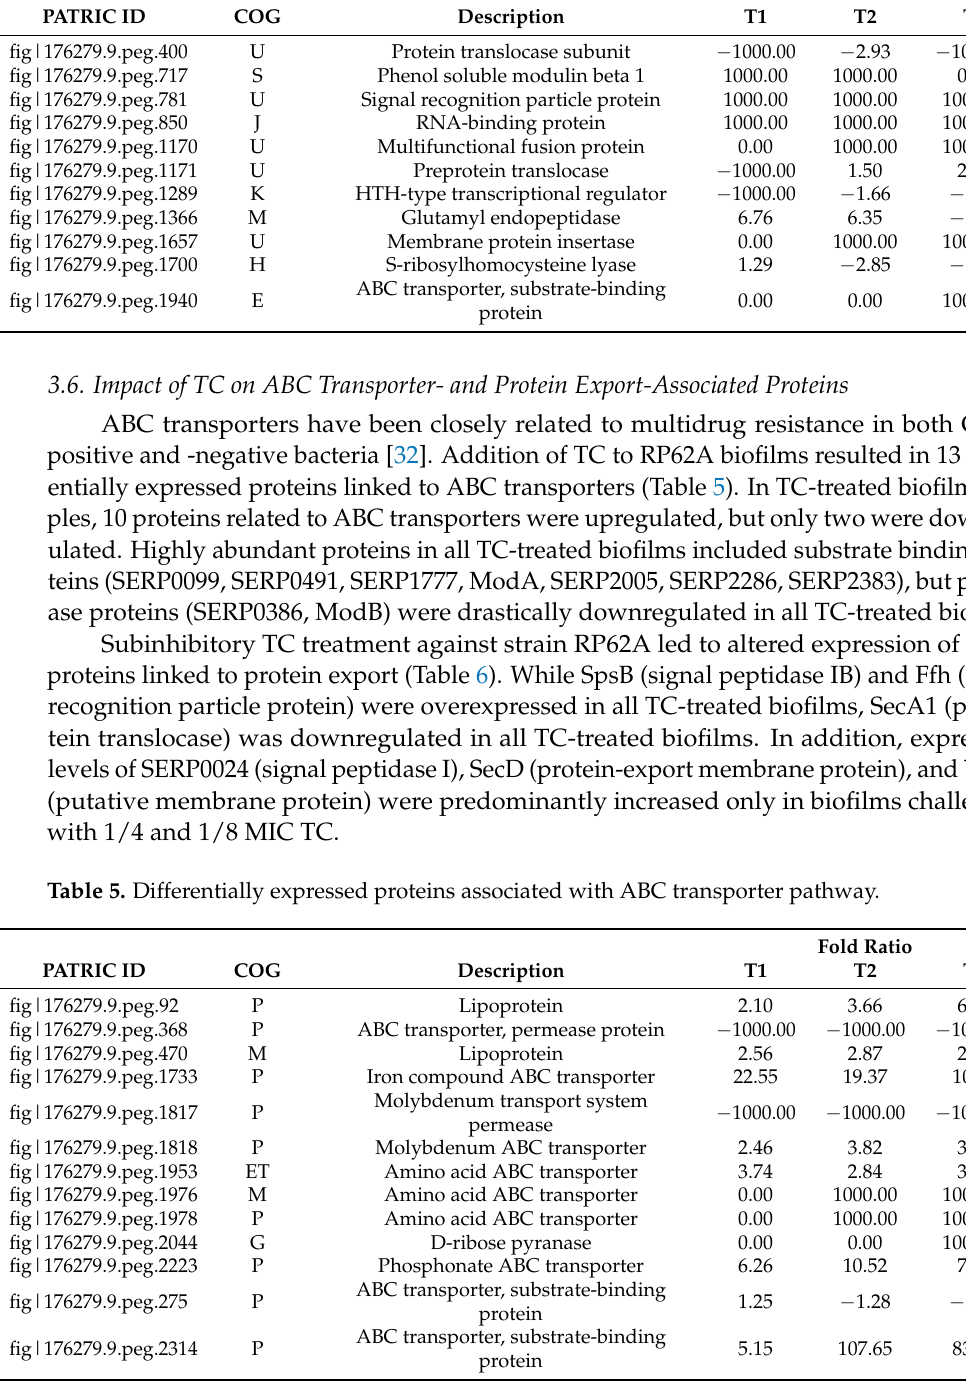
fig|176279.9.peg.368